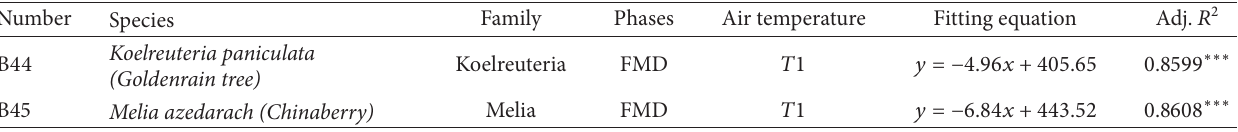
(Figure 4(a)), Waxberry Cultural Festival of Xinglong Town (Figure 4(c)), and Grape Tourism and Cultural Festival of Bishan District (Figure